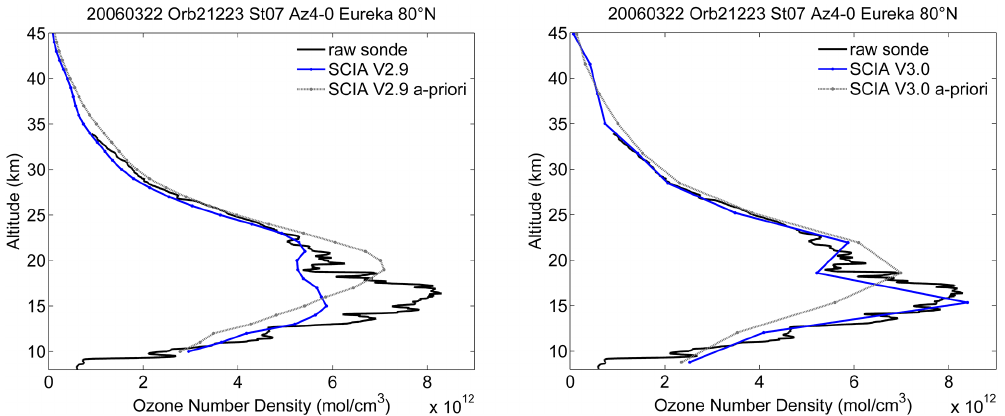
Figure 9. Comparison of ozone vertical profiles from SCIAMACHY and from ozonesonde at the Eureka